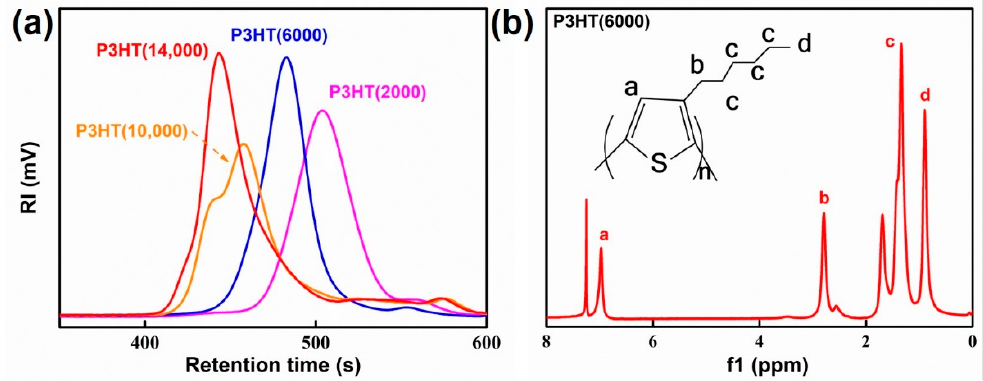
Figure 2. ( a ) Gel permeation chromatography (GPC) spectra of poly(3-hexylthiophene) (P3HT) with